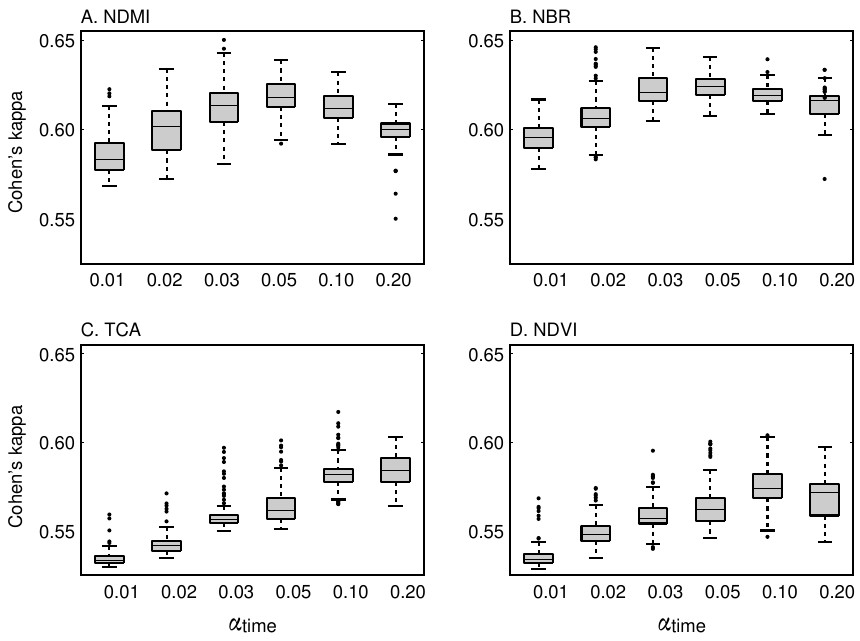
Figure 7. Effect of the strength of the temporal fidelity parameter on performance (kappa) within each vegetation index ( A – D ). Higher values of α time represent less fidelity to the original time series and longer segments. Lower values represent a closer tracking of the time series and shorter segments.